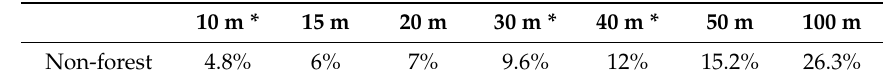
Table 2. Calculated share of the transition zone (TZ), in the area of Brandenburg, for the different TZ